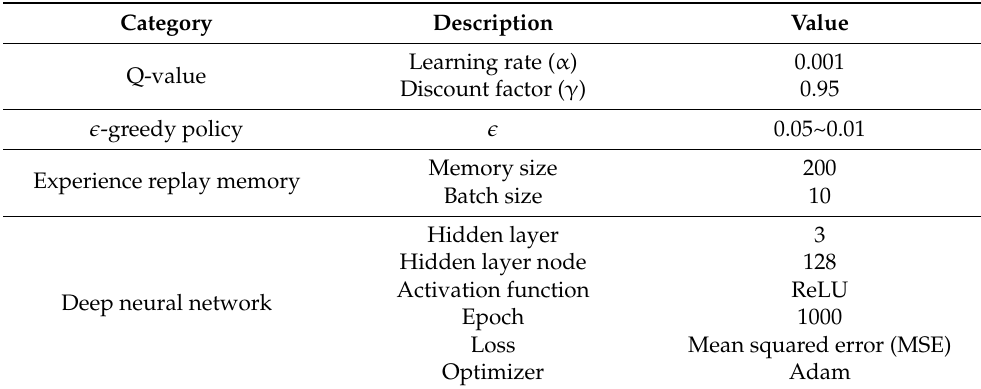
Table 12. Deep RL applied